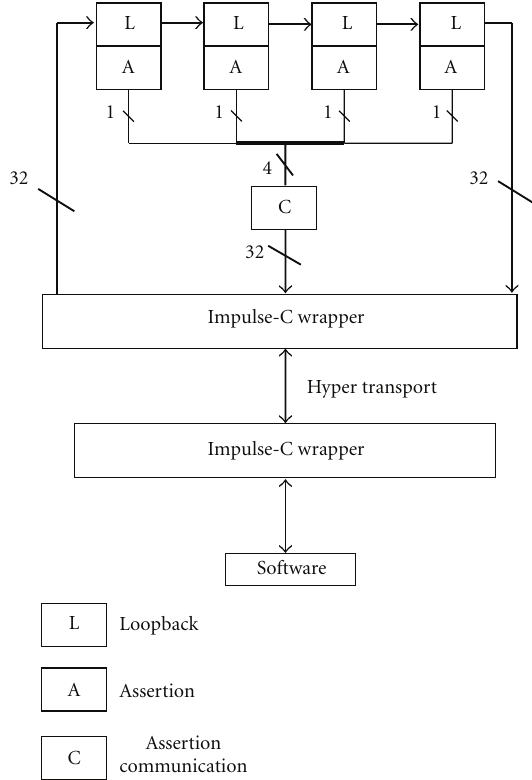
Figure 9: Simple streaming loopback.